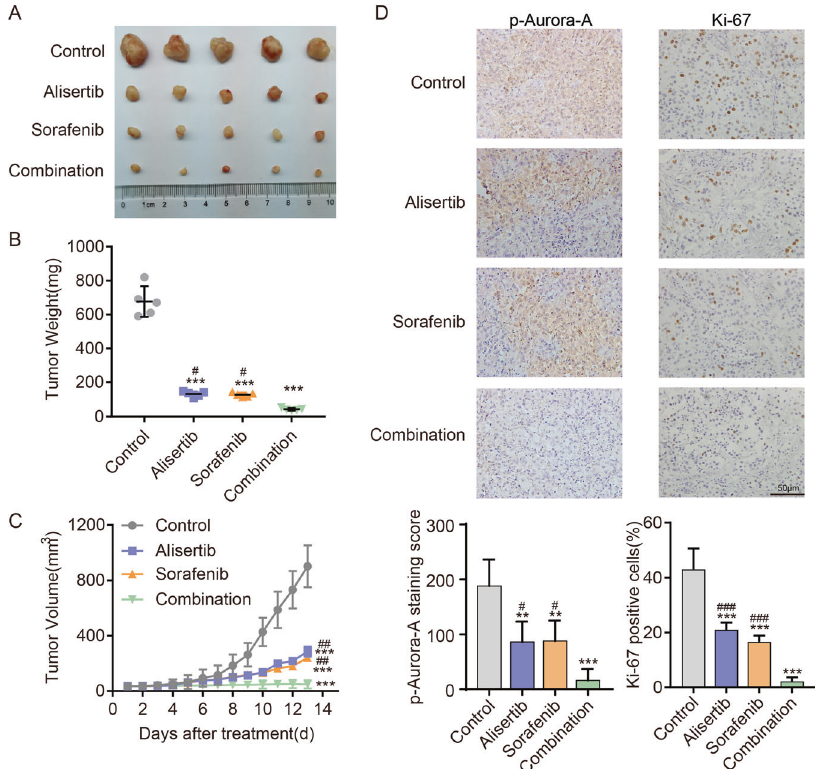
Fig. 6 The combination of Alisertib and Sorafenib is a promising therapeutic approach for advanced TC in vivo. A Representative images of subcutaneous xenografts in NSG mice injected 8305 C cells treated with Alisertib (30 mg/kg), Sorafenib (30 mg/kg) or both drugs. n = 5 mice per group. The subcutaneous xenografts were dissected on day 13. B , C Tumor volumes were measured with tumor weights ( B ) and growth curves ( C ) in each group. D The expression levels of Ki67 and p-Aurora-A in xenografts of each group were assessed